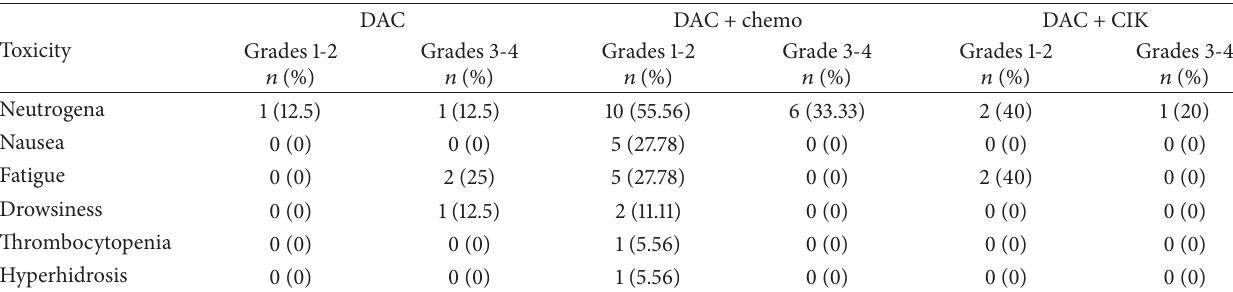
Figure 2: Trial profile. ( ∗ ) Reasons for not meeting the inclusion criteria: patient had a massive hemorrhage ( 𝑛 = 1 ). CIK: cytokine induced killer cells. DAC + Chemo: DAC combined with chemotherapy group; DAC + CIK: DAC combined with CIK group. Table 3: Summary of adverse